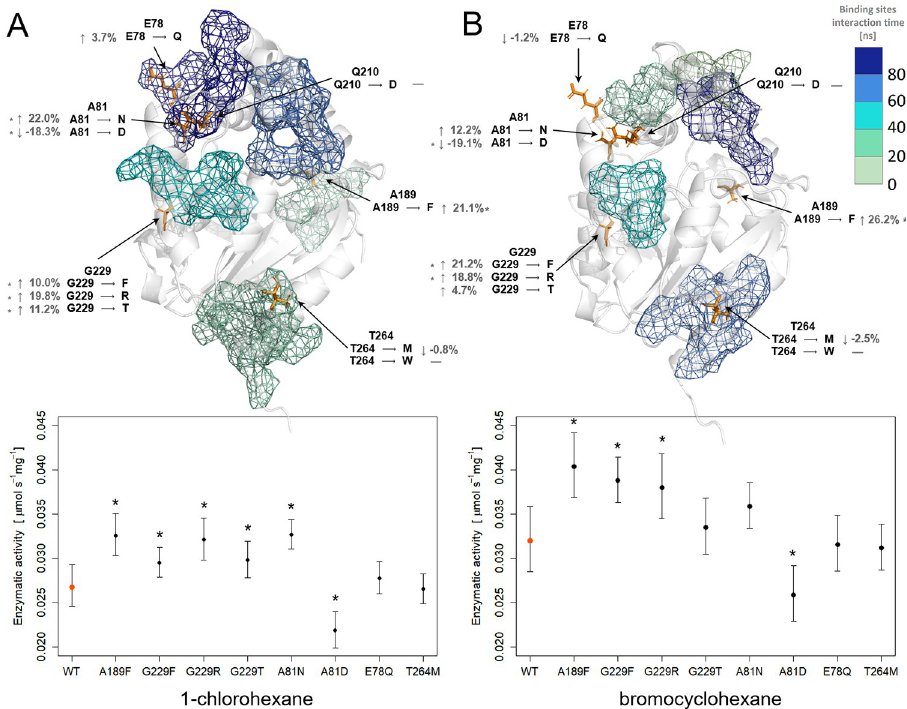
Fig 3. Activity of the LinB mutants determined experimentally in the reaction with (A) 1-chlorohexane and (B) bromocyclohexane along with transient binding sites calculated in silico for respective substrates. Mutated amino acids shown as orange sticks. Transient binding sites shown as mesh coloured according to length of interaction time with a selected ligand. Information on the changes in activity measured experimentally (in grey) of a selected mutation (in black). The plots underneath show forecasted mean values and associated confidence intervals of the forecasted values for experimental activity measurements of protein with (A) 1-chlorohexane and (B) bromocyclohexane. The asterisk above the point indicates a statistically significant difference in WT (red point) activity relative to the